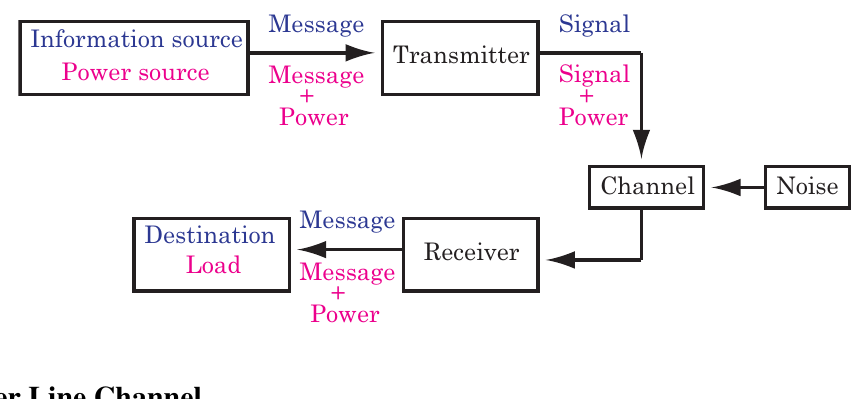
Figure 5. Schematic diagram comparing a general communication system and a power packet dispatching system. Communication and power packet dispatching systems are indicated in blue (upper) and red (lower),